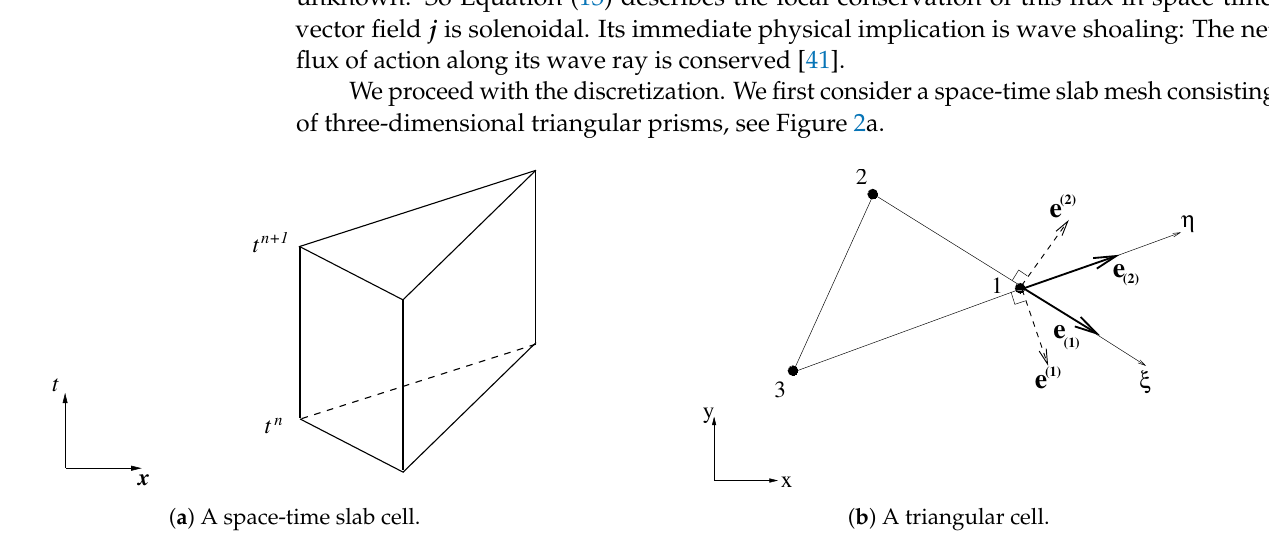
Figure 2. Local computational cell. Definitions of quantities and notations are provided in the text. The bottom and top of each prism are the triangular cells at time levels t n and t n + 1 , respectively. Furthermore, the prism has three rectangular lateral faces. The discretization of Equation (13) is associated with each of these prisms acting as control volumes. In terms of discrete forms it is then given